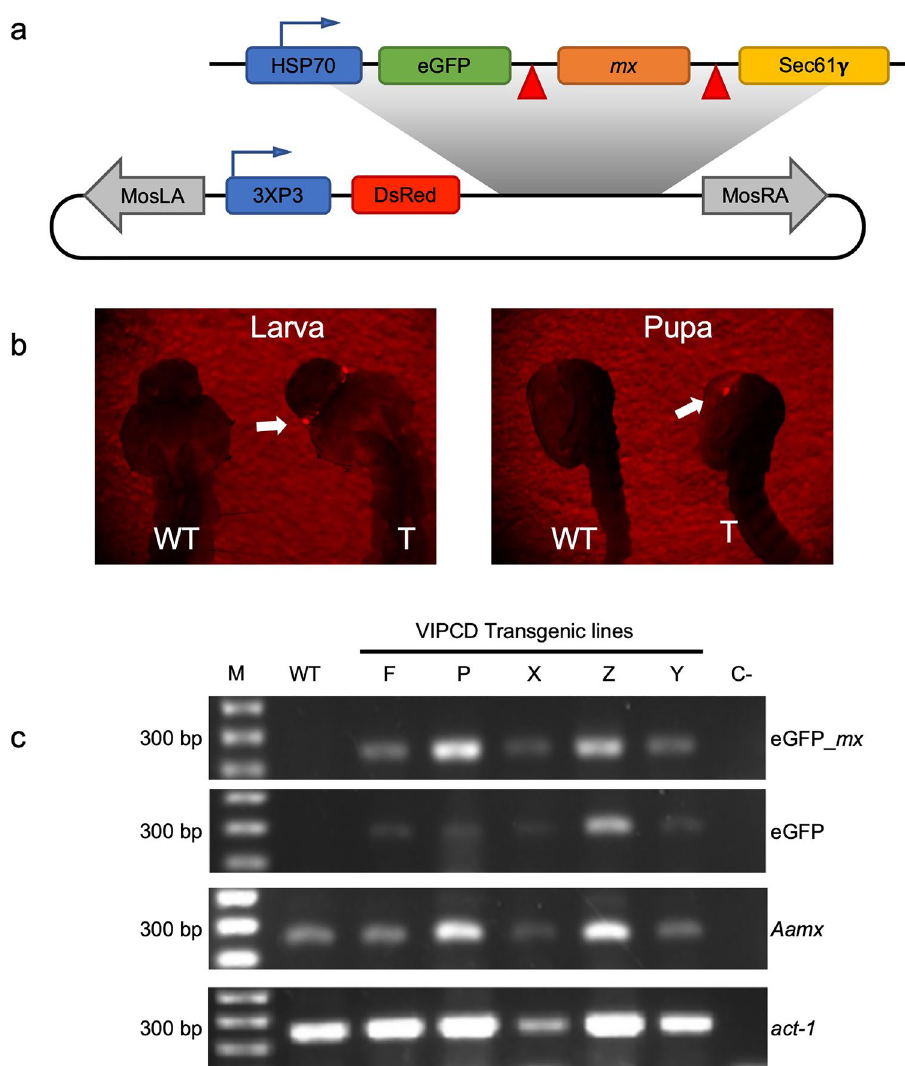
Figure 3. Description of VIPCD transgenic lines. ( a ) Schematic representation of the VIPCD construct subcloned into the transposon vector, pMos-DsRed (blue arrows indicate the promoter orientation) resulting in the donor plasmid pMos[3xP3-DsRed-hsp70-VIPCD]. HSP, heat-shock 70 promoter; eGFP, enhanced green fluorescent protein; red triangles, the RRRRSAG cleavage motif for NS2B/NS3; mx, michelob_x; Sec61γ, endoplasmic reticulum transmembrane domain. MosLA and MosRA, inverted terminal repeat sequences from the mariner Mos1 transposable element; 3xP3, eye-specific promoter; DsRed, Discosoma red fluorescent protein expressed in the mosquito eye to identify transformants. ( b ) DsRed marker gene expression in Ae. aegypti (HWE) mosquitoes transformed with pMos[3xP3-DsRed-VIPCD]. Arrows point to the fluorescent protein expression in the eyes of transgenic larval and pupal stages under fluorescent light using a stereo microscope with a FITC-Texas Red filter. T, transgenic; WT (non-transformed HWE). ( c ) RT-PCR based expression profile of the VIPCD transgene in five transgenic lines (F, P, X, Z, and Y). The transcription profile of the VIPCD transgene was confirmed for all five transgenic lines by the amplification of expected fragments using specific primer sets to detect eGFP_mx (eGFP fused to mx) and eGFP. To confirm the integrity of cDNAs and the endogenous presence of mx, the endogenous Aamx and Actin-1 (Act-1) genes were amplified. M, molecular weight marker: 200 bp, 300 bp, and 400